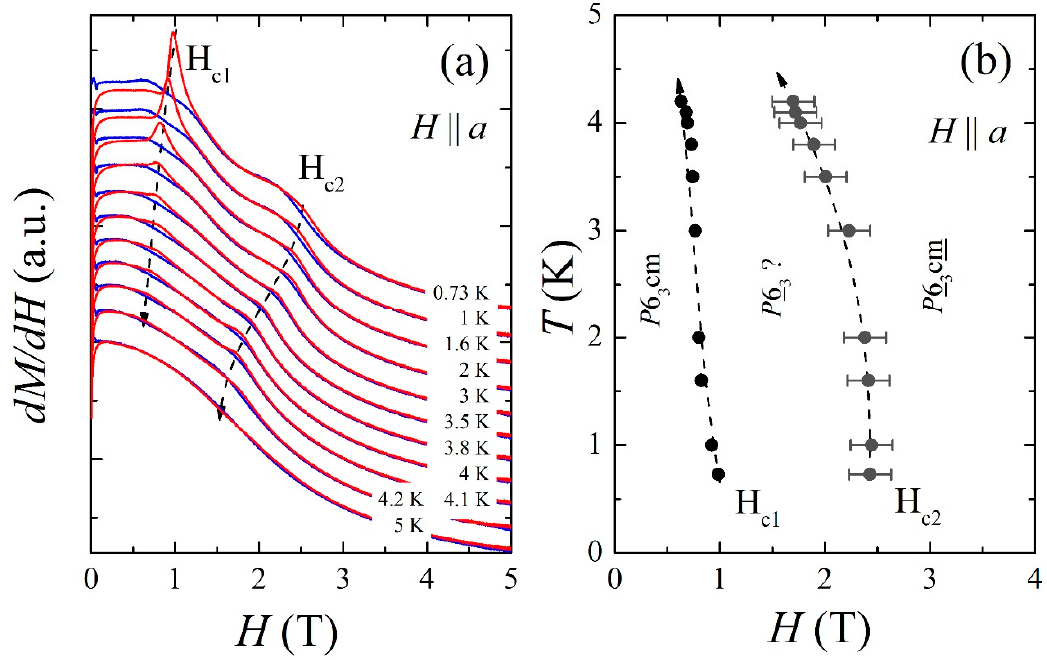
Figure 3. ( a ) d M / d H curves measured from 5 to 0.73 K for H // a . The red (blue) curve is for the increasing (decreasing) field. ( b ) H - T phase diagram for H // a . The error bar indicates the broad peak at H c2 . The dashed lines are guided for eyes.